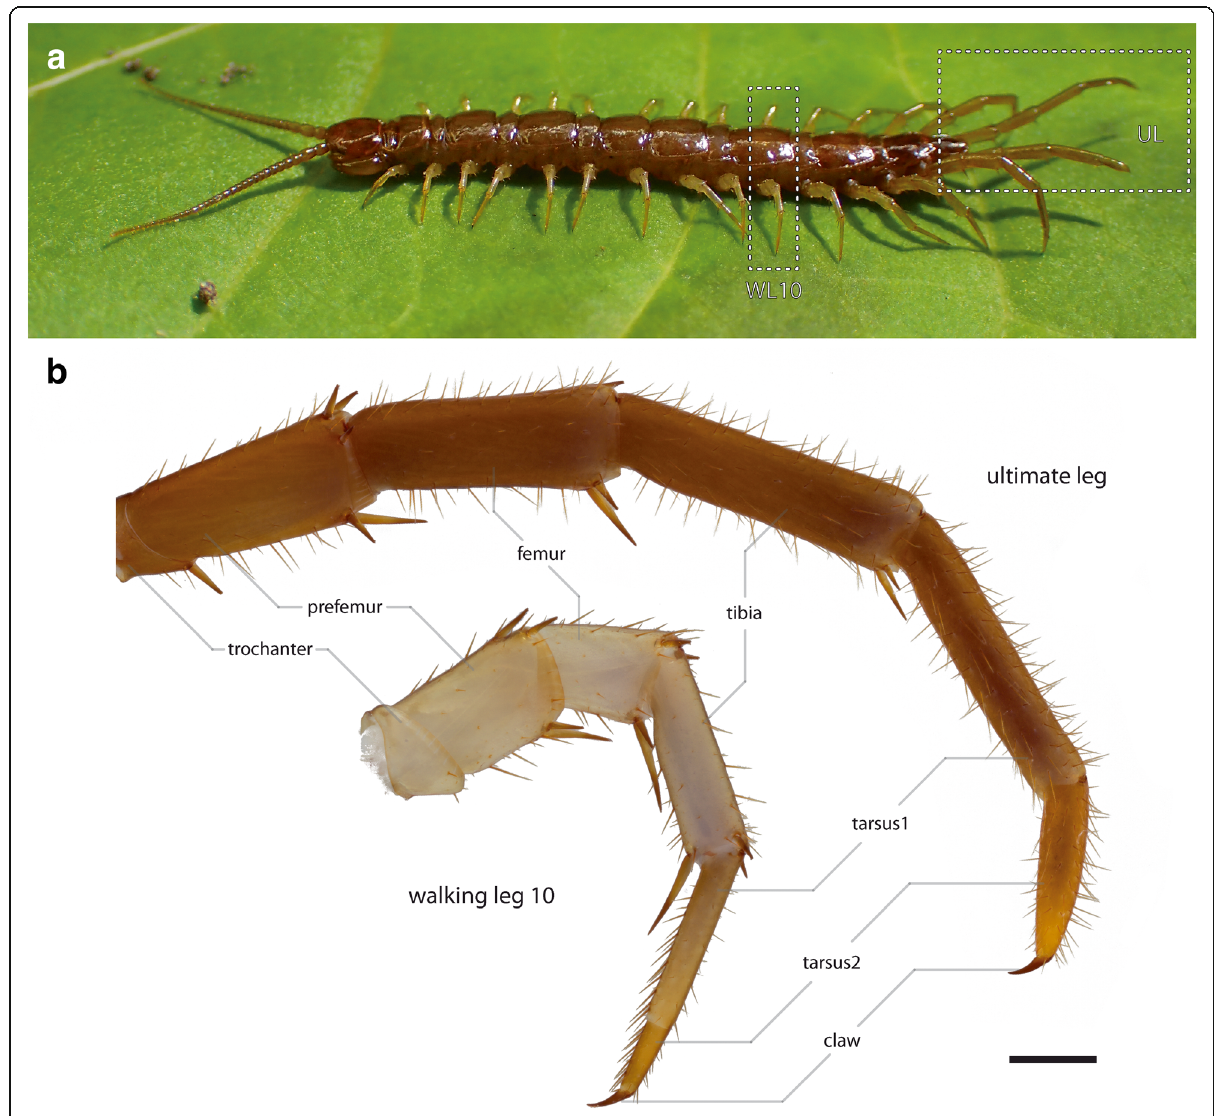
Fig. 1 Lithobius forficatus . a Habitus, view from lateral. Dashed rectangles indicate walking legs 10 and the ultimate legs. Note that the left ultimate leg (front) was damaged and regenerated. b Macrophotographs of ultimate leg (top) and walking leg 10 (bottom) from the same specimen, to scale. Coxae of both legs not shown, trochanter only partially shown. Note the difference in length of corresponding podomeres. Scale bar 500 μ